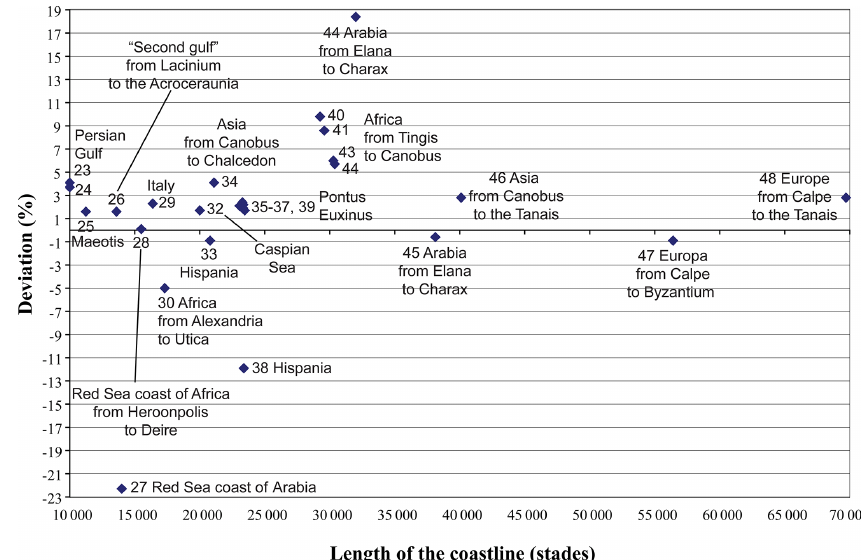
Figure 4. Deviation of Ptolemy’s coastline length values from those given in the periploi -based sources for the distances over 10000 stades (as expressed in the percentage terms). Ptolemy’s data are mostly taken from (cid:52) and in a few cases from (cid:127) (nos. 23–24, 27, 32, 44–45). Nos. 31, 49–51 are omitted since they are the sums of the other values.